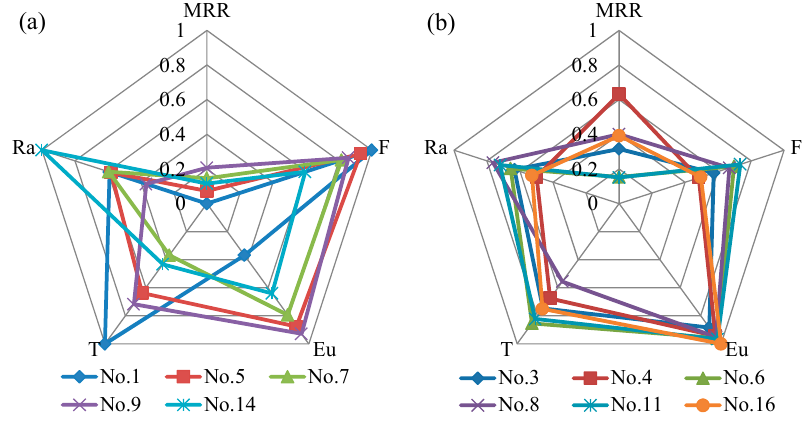
Figure 16. Typical radar diagrams for ( a ) bad, and ( b ) good machinability in asymmetric up-milling TC25.